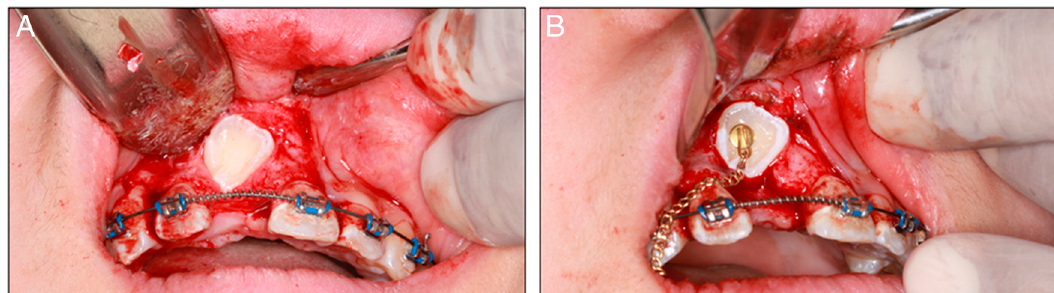
Figure 7. (A) Surgical exposure of the impacted 11; (B) Placement of the button with gold chain on the 11.